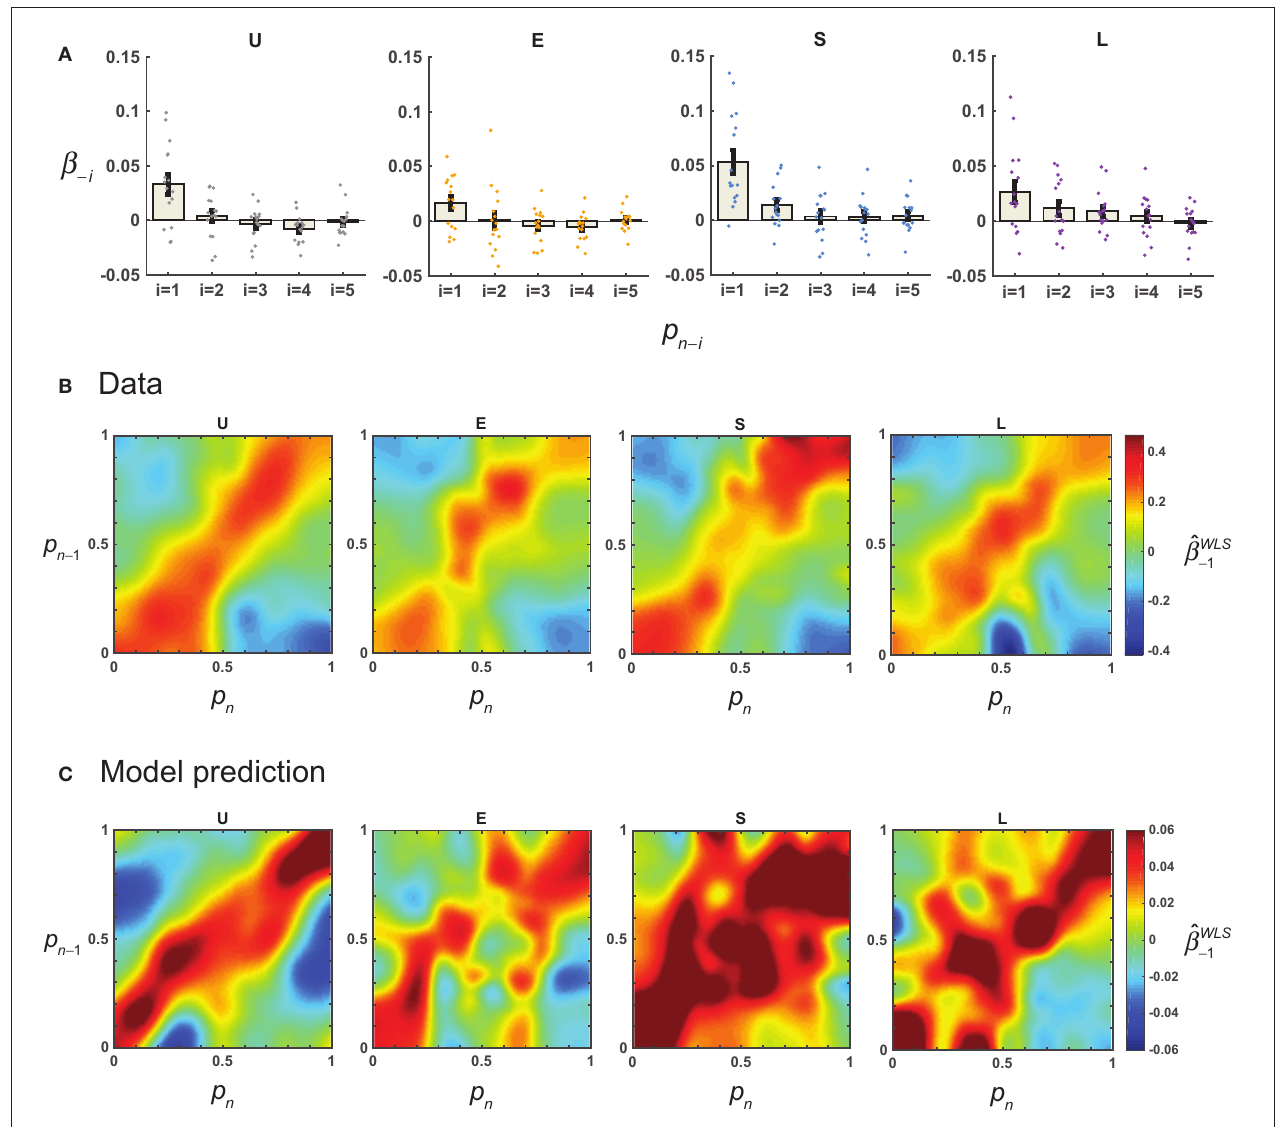
FIGURE 4 | Results: sequential effects. For each participant, linear regression was performed to quantify the possible influence of the previous response on the current response (Equation 12), and how this sequential effect—as quantified by the coefficient for the previous response, β the current ( p n ) and previous trials ( p n 1 ). (A) Sequential effects for more than one trial back. The estimated mean β − trials back is plotted for each distribution condition. Error bars denote 1 SE. Dots denote estimates for individual participants. (B) Sequential effects as a function of p n WLS and p n across participants is plotted separately for the four conditions. Note that the closer the p n 1 . The mean ˆ β − − 1 AL-NL model’s predictions for sequential effects.